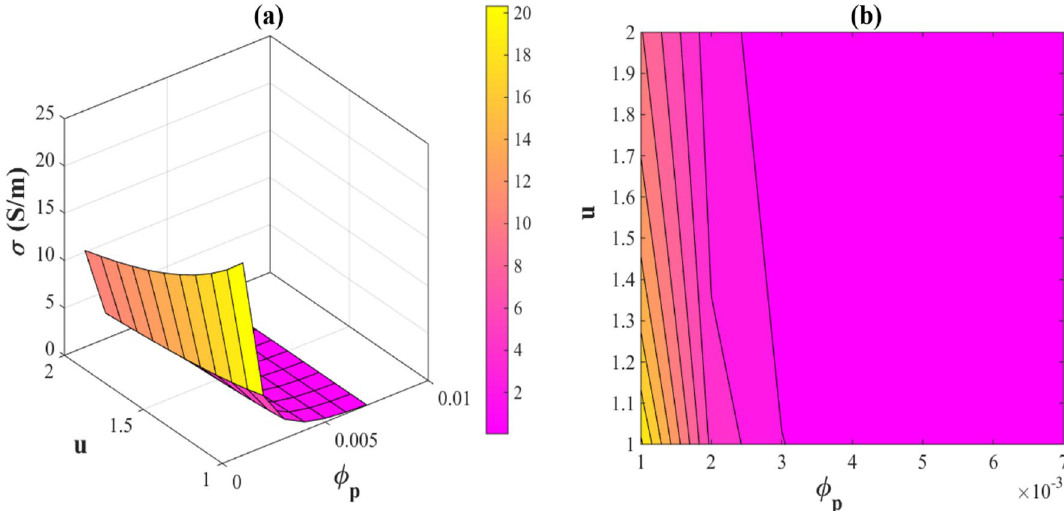
Figure 7. Electrical conductivity of a PNC by “ ∅ p ” and “u”: ( a ) 3D and ( b ) contour